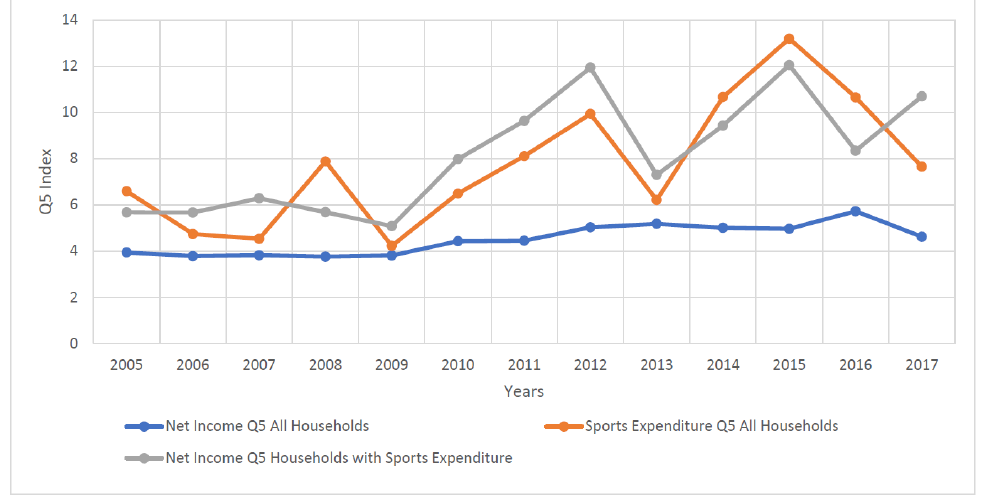
Figure A5. Q5 inequality indices in the time period 2005 – 2017. Source: own calculation.